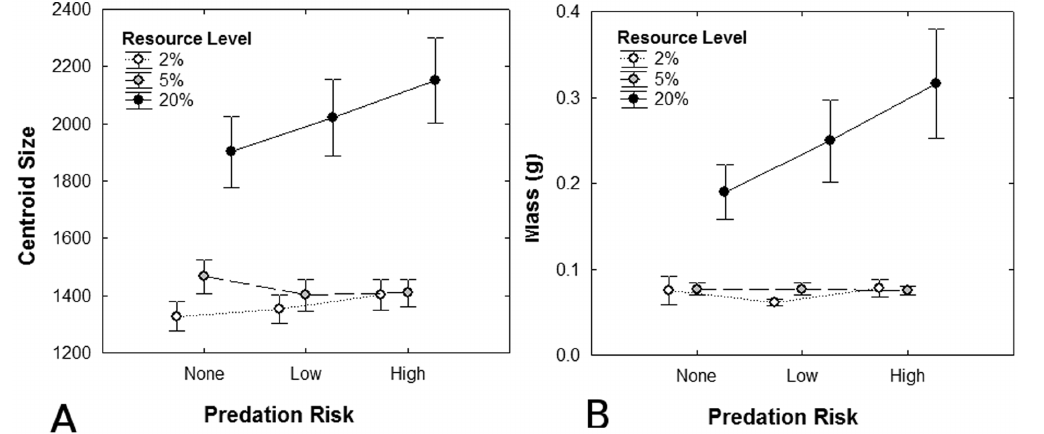
Figure 2. Interaction plots of resource level (2%: severe restriction, 5%: moderate restriction, 20%: saturation) and predation risk (none, low, high) on mean ( ± 95% CI) A: Centroid Size and B: Mass (g) of Northern leopard frog ( Lithobatespipiens ) tadpoles.